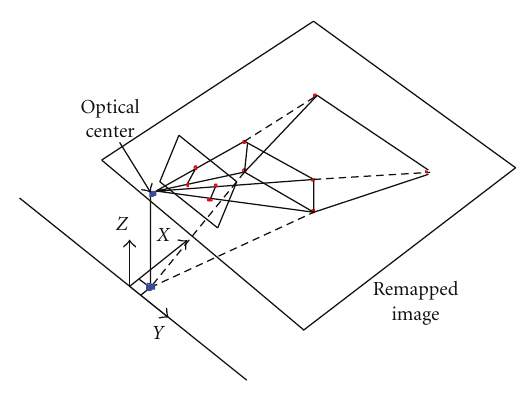
Figure 2: The vertical line projection of (1).